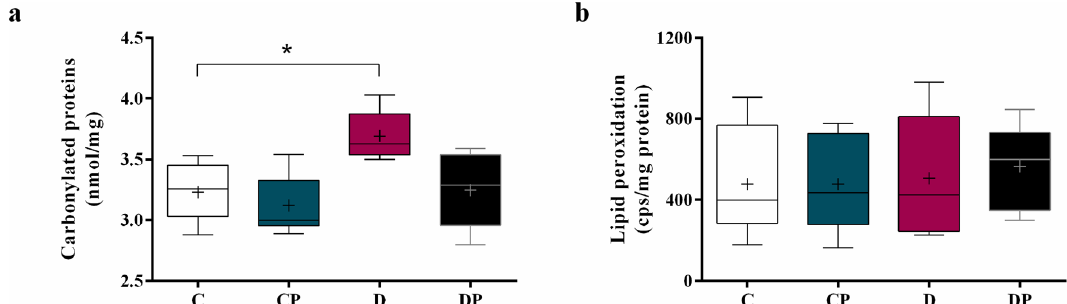
Figure 7. Carbonylated proteins (nmol/mg) and lipid peroxidation (cps/mg protein) in hepatic tissue of control (C), control + probiotic (CP), diabetic (D) and diabetic + probiotic (DP) groups (n = 6–9/group). Data are from C57BL/6 STZ-induced diabetic mice, + /- Saccharomyces boulardii (0.5 × 10 8 colony-forming units, THT 500,101 strain , Probiotics and Starters Cultures, Belgium) for 8 weeks. A horizontal line inside the box indicates the median value of the samples within each group, and the upper and lower edges of the box indicate the quartiles. For (a) the significance was determined by Kruskal–Wallis followed by Dunn’s test and for (b) the significance was determined by Two-way ANOVA followed by Tukey test for multiple comparisons of means (GraphPad Prism 6). + indicates mean value. *p ≤ 0.05.